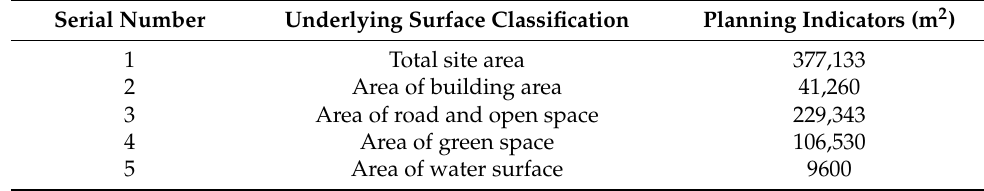
Table 4. Statistics of the urban planning underlying surface classification of the study area.